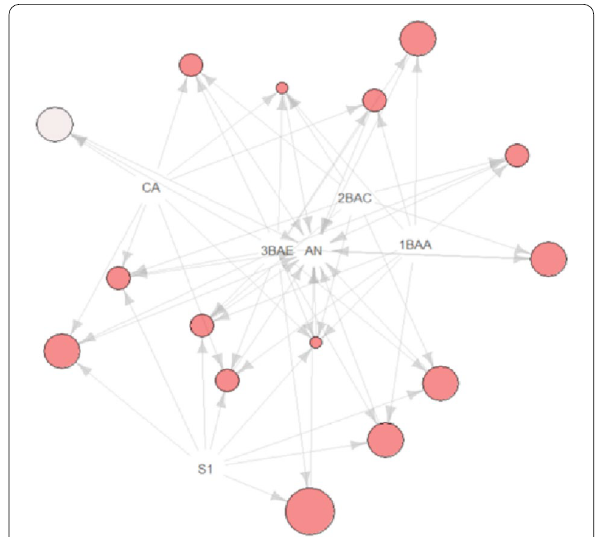
Figure 10 Schematic diagram of strong association rules with RHS item as “AN”